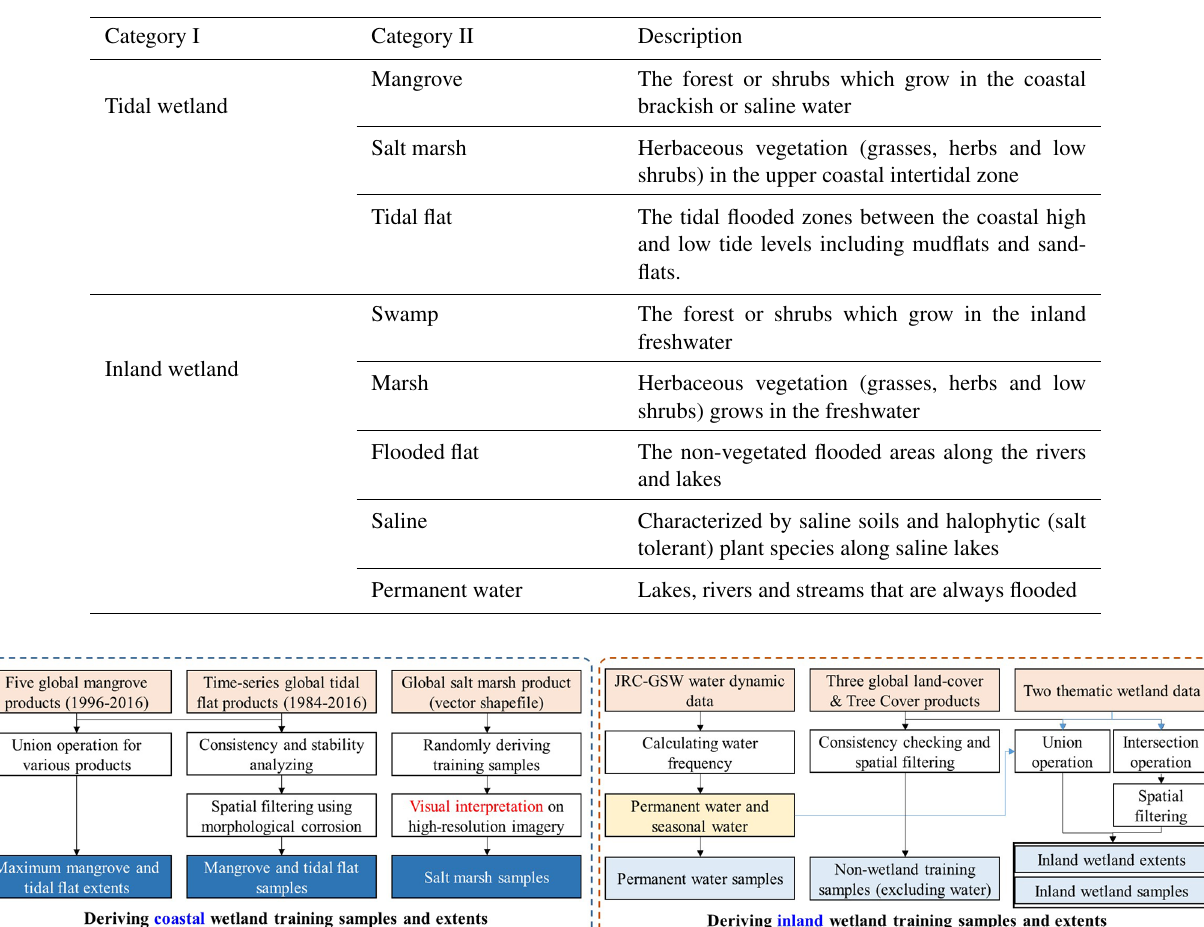
Table 2. The description of the wetland classification system in this study.